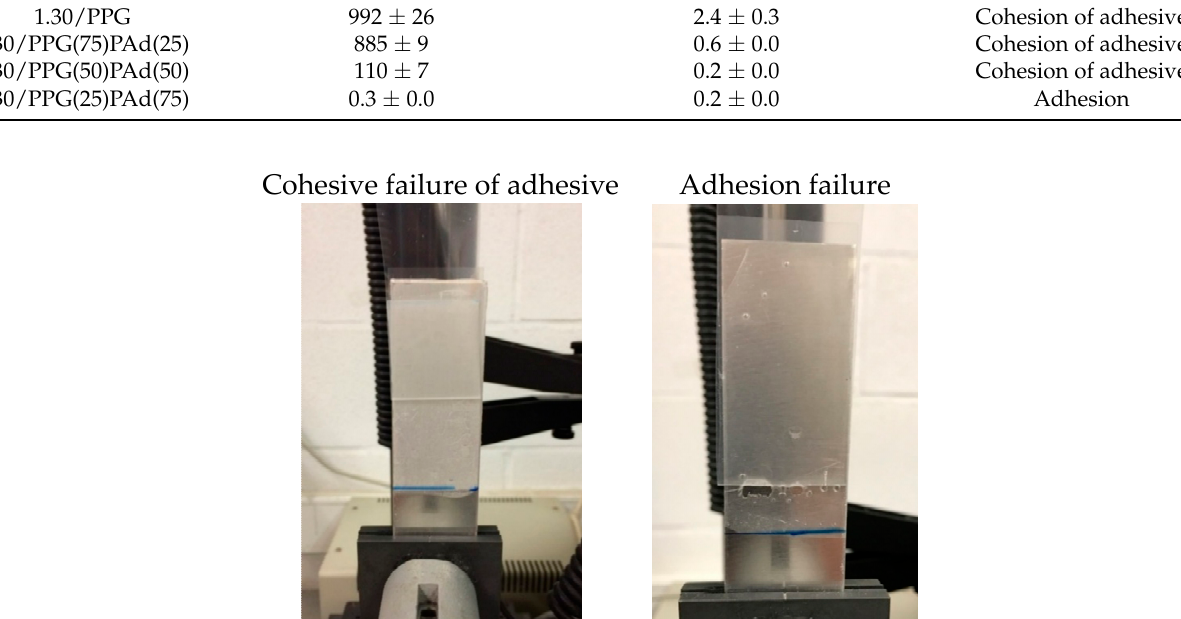
Figure 9. Variation of the storage (G (cid:48) ) and loss (G (cid:48)(cid:48) ) moduli at 25 ◦ C as a function of the frequency Figure 9. Variation of the storage (G ′ ) and loss (G ″ ) moduli at 25 ° C as a function of the frequency for the TPUs. Frequency sweep plate-plate rheology experiments. for the TPUs. Frequency sweep plate-plate rheology experiments. Table 8. Probe tack and 180° peel strength values, and loci of failure of aluminum 5754/TPU PSA Table 7. Viscoelastic properties of the TPUs related to their PSA characteristics. Frequency sweep plate-plate rheology Table 8. Probe tack and 180 ◦ peel strength values, and loci of failure of aluminum 5754/TPU PSA joints. joints. experiments. TPU PSA